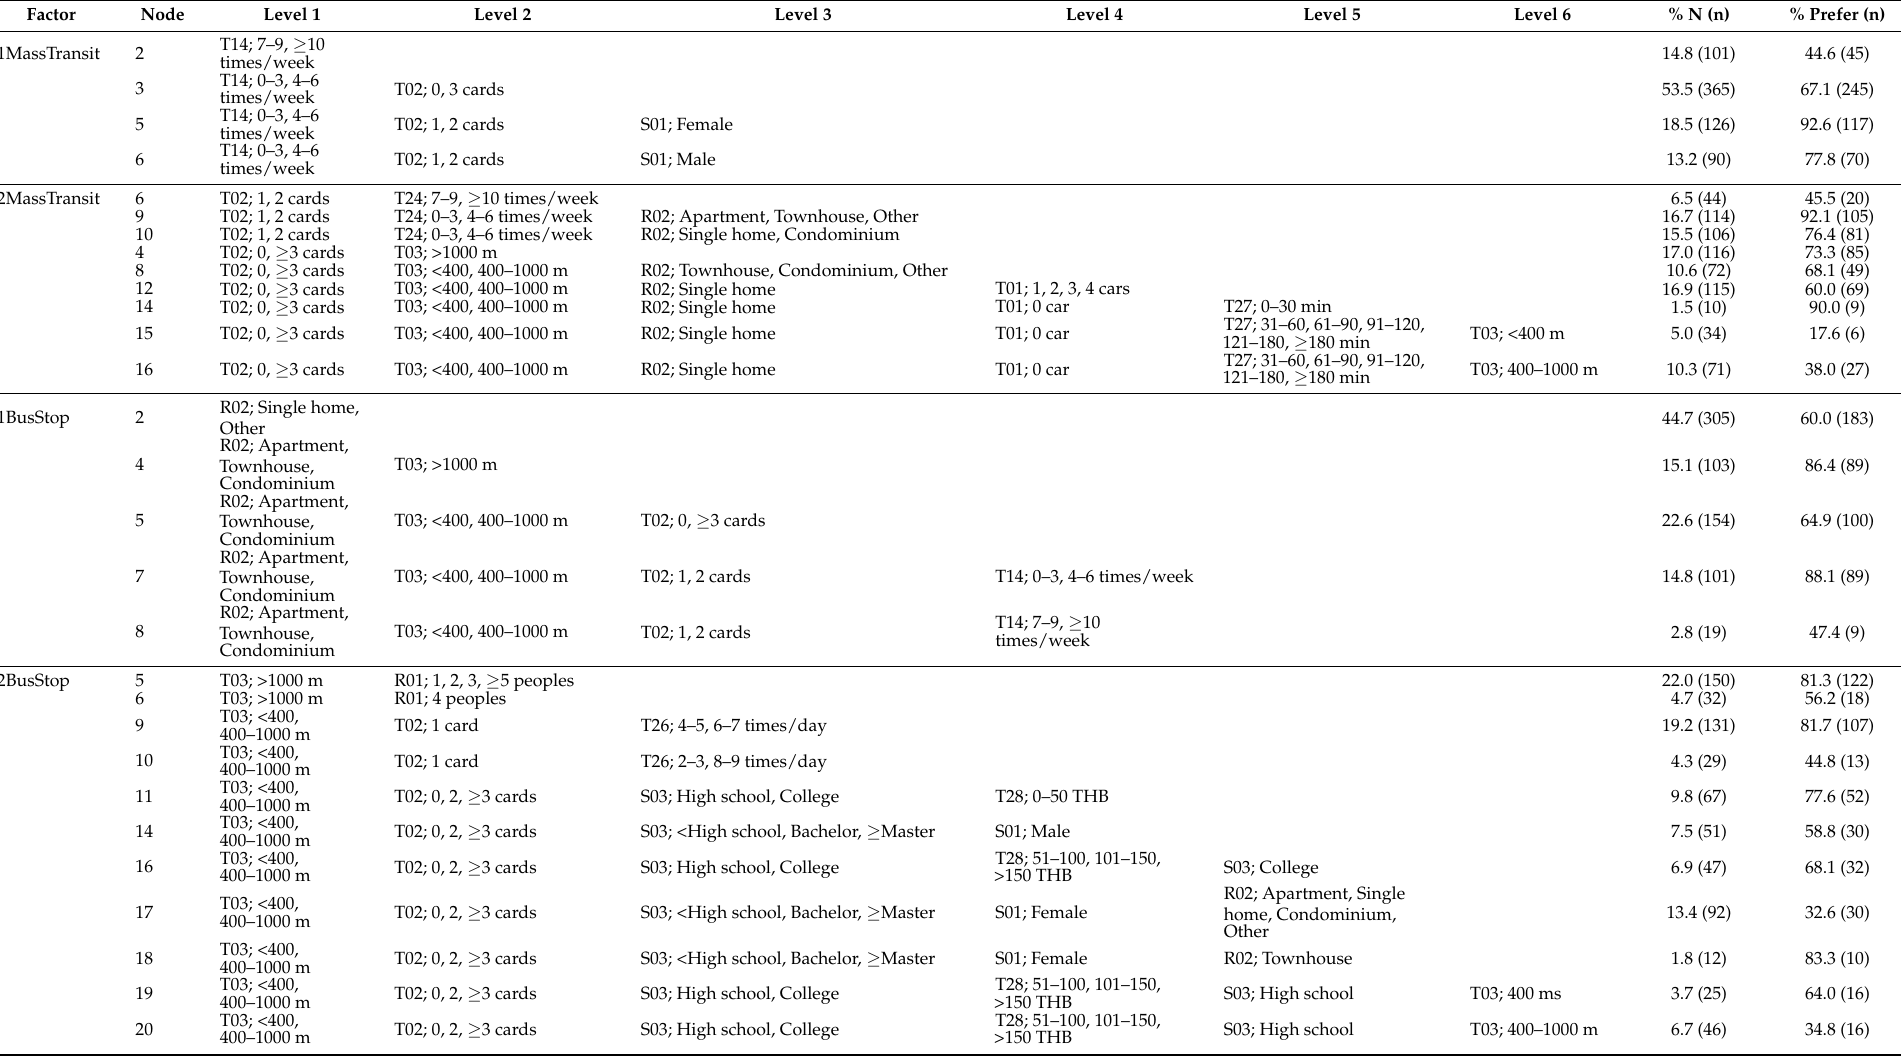
Table 6. Relevant segmentation of attitudes toward residential accessibility and the decision rules for terminal